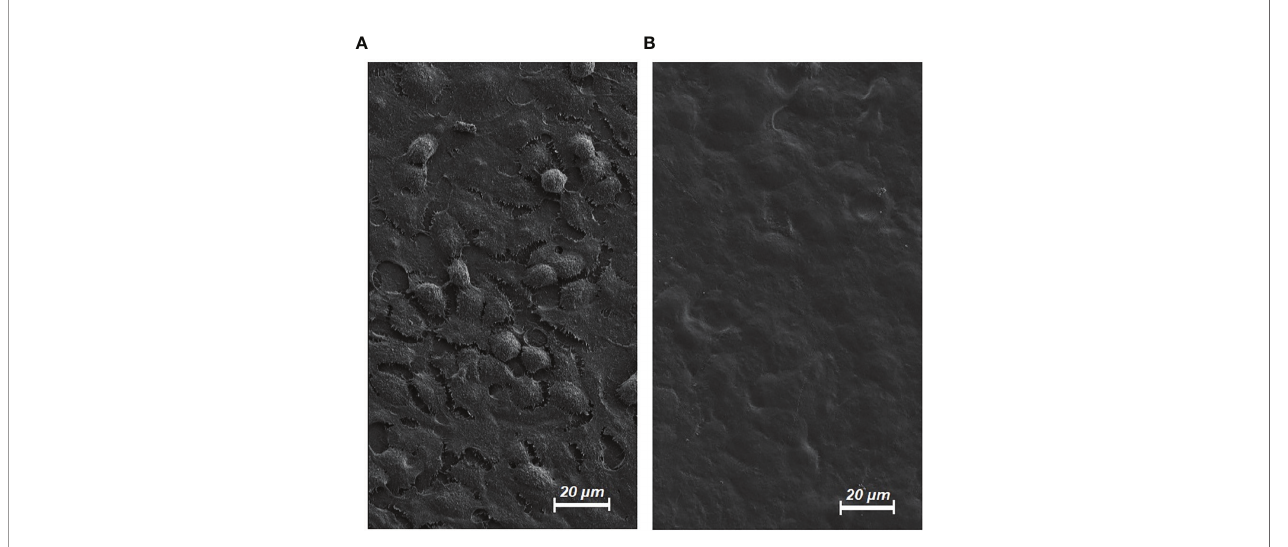
FIGURE 6 | Electron microscopy (EM) of HT-29 cells. (A) Untreated HT-29 Cells in EM (control/magni fi cation level 1000X). (B) HT-29 Cells in EM following dehydration and hyperthermia for 20 minutes (magni fi cation level